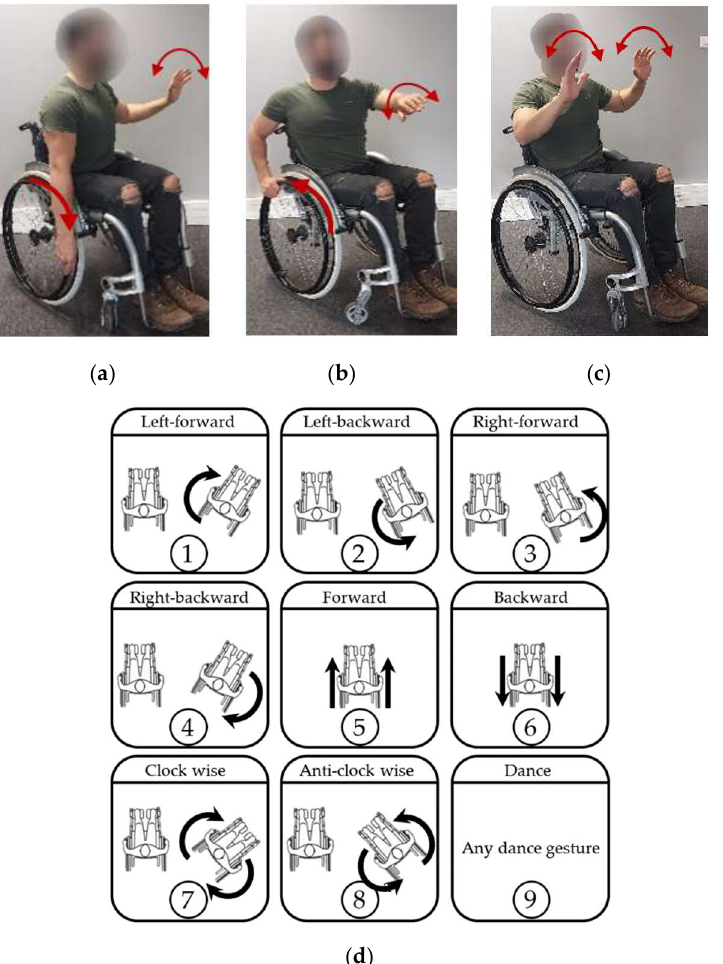
Figure 5. Propulsion and dance gestures: ( a ) “right- forward” gesture, ( b ) “right- backward” gesture, ( c ) dance gesture, and ( d ) all gestures to be